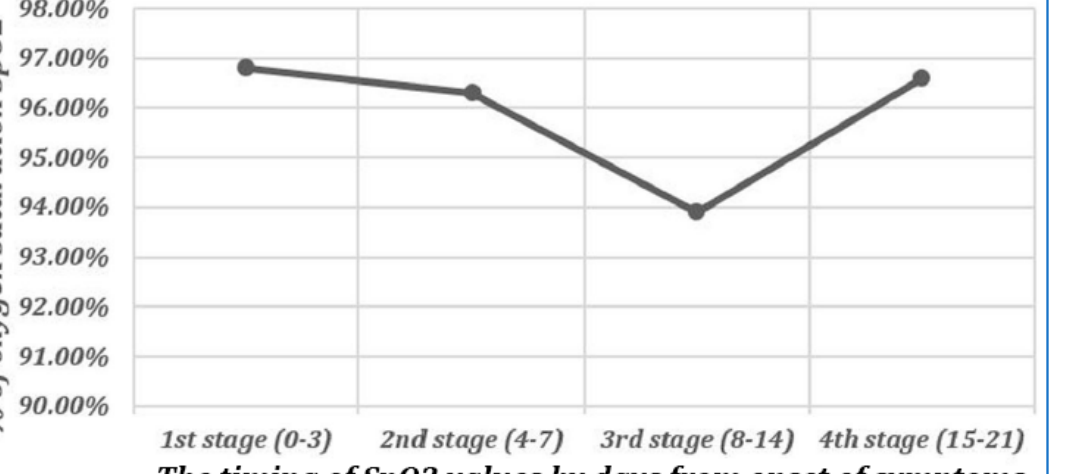
Figure 4. Changes in SpO2 over 3 h for a COVID-19 patient after administration of IVM. SpO2 values are shown (all on room air), with pulse rates (bpm) below those, at pre-treatment ( A ) and for 45 min ( B ), 90 min ( C ), and 3 h ( D ) after first dose of IVM. This patient, a 25-year-old male, was diagnosed with COVID-19 by a positive result from a rapid antigen test and treated with combination therapy including IVM, doxycycline, and zinc plus other oral and nebulized adjunct agents from among those itemized above.